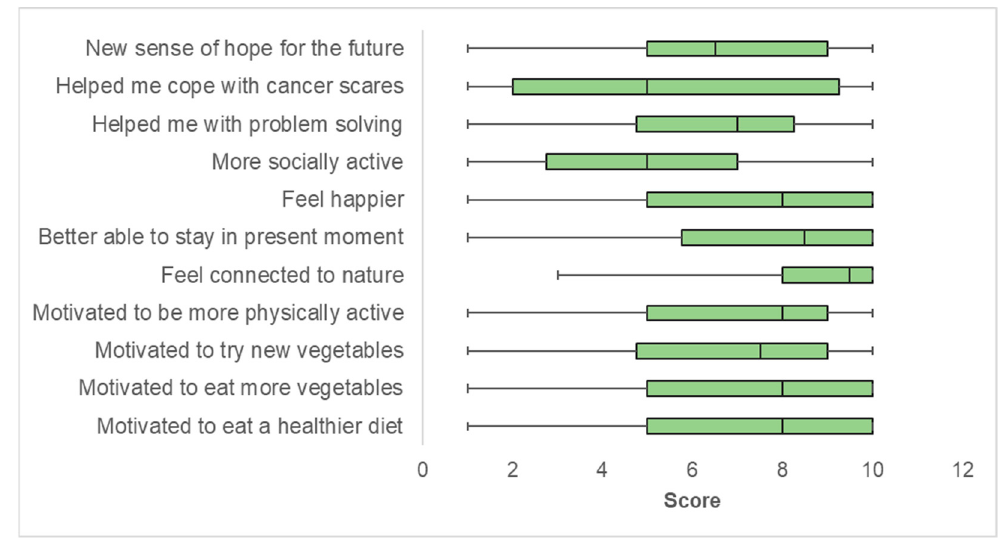
Figure 1. Impact of a home-based vegetable gardening intervention on diet, physical activity, and well-being. Shaded areas represent the interquartile range. Vertical lines within each shaded region represent the median score. Whiskers represent the minimum and maximum scores for the questions, ranging from 1 (not at all) to 10 (very much).